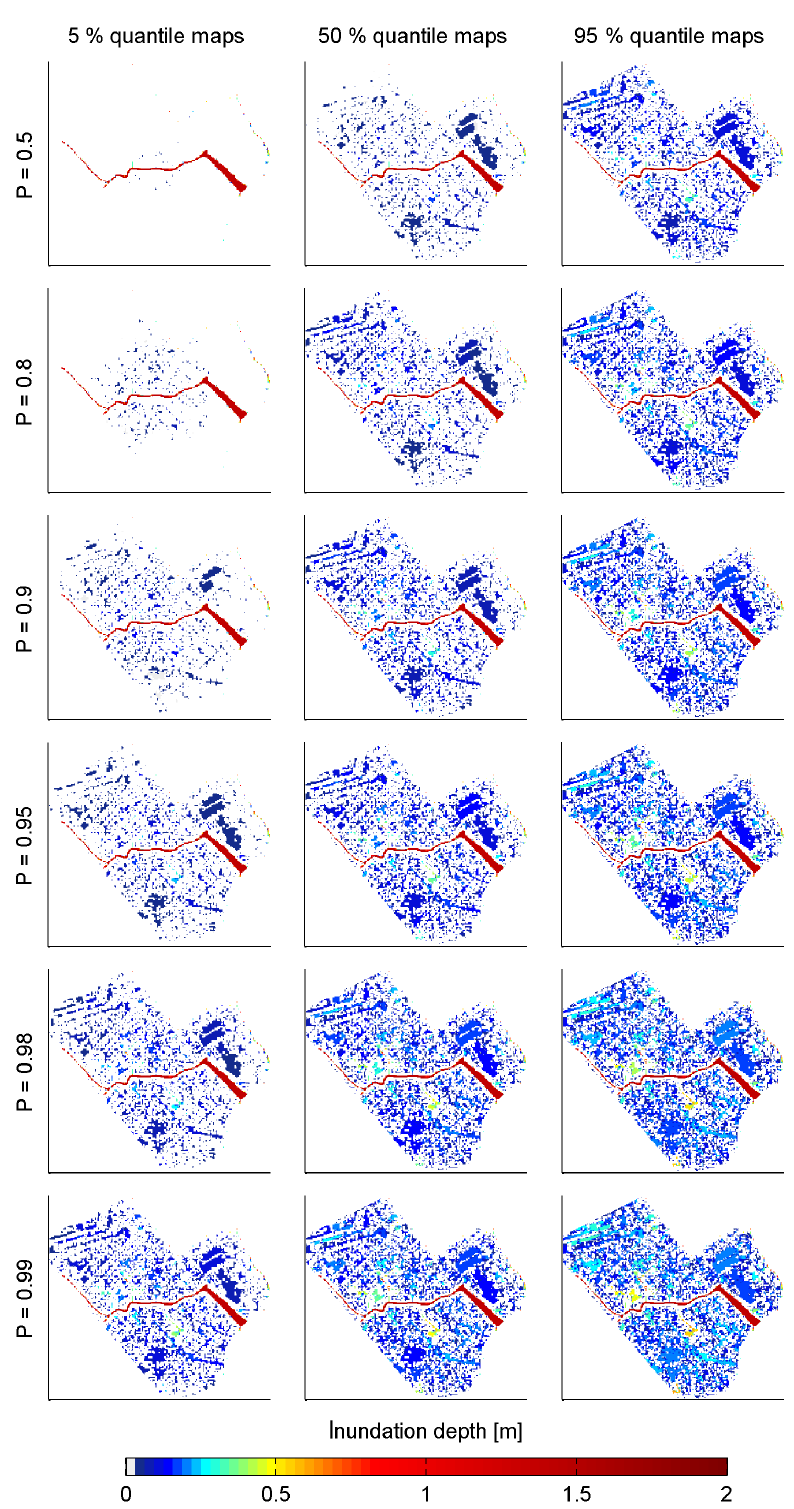
Figure 13. Probabilistic pluvial flood hazard maps for Can Tho showing maximum inundation depths: for the selected p levels (annual probabilities of non-exceedance) the median (50% quantile) maps and associated 5 and 95% quantile maps are shown illustrating the uncertainty of the hazard estimation. Maximum inundation depths < 0.02m are indicated as no